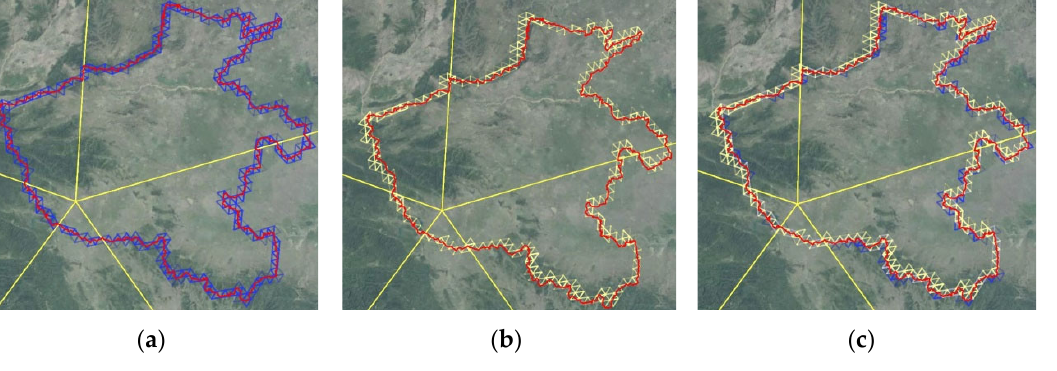
Figure 16. Comparison diagram of the ninth level triangle discrete lines of HtoTcode and longitude– latitude. ( a ) The ninth level triangle discrete lines of longitude–latitude; ( b ) the ninth level triangle discrete lines of longitude–latitude; ( c ) the ninth level discrete lines superposition of longitude– latitude and HtoTcode .